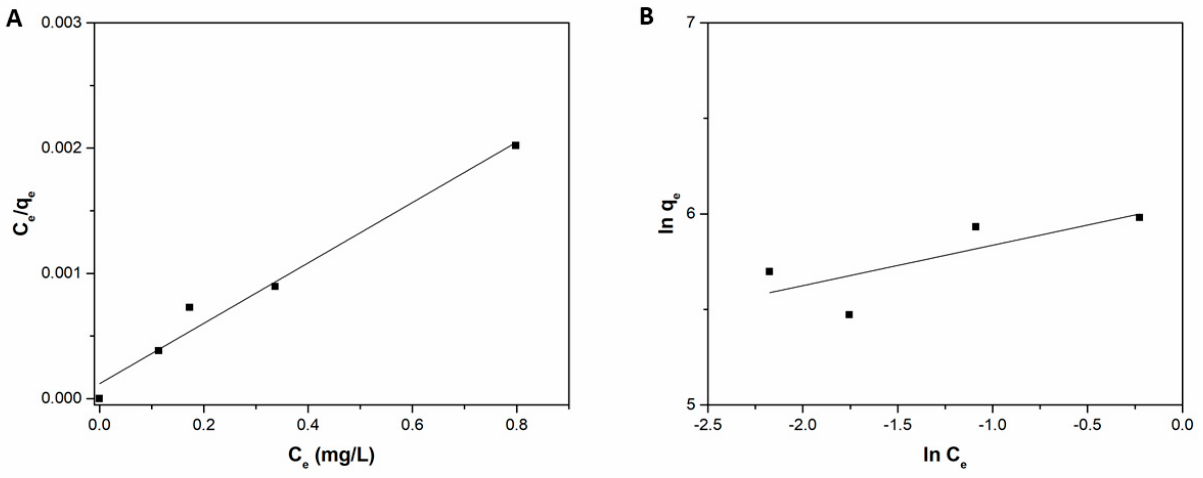
Figure 7. ( A ) Langmuir and ( B ) Freundlich isotherms for the adsorption of MB onto Liposome@PDA microspheres. Table 3. Isotherm parameters for MB adsorption onto Liposome@PDA microspheres at 298 K.